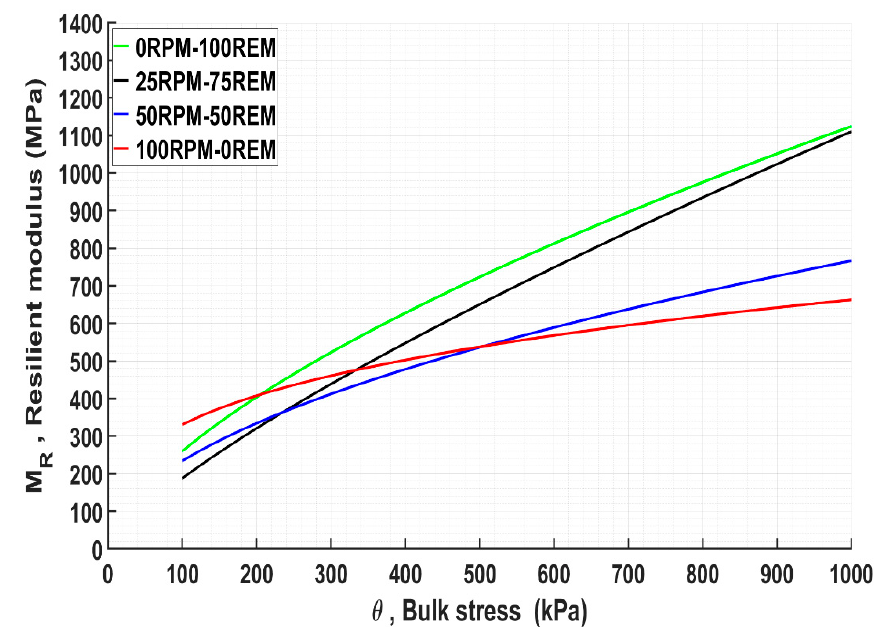
Figure 5. Resilient modulus of pure REM and RPM and blended mixtures by Hicks and Monismith model.